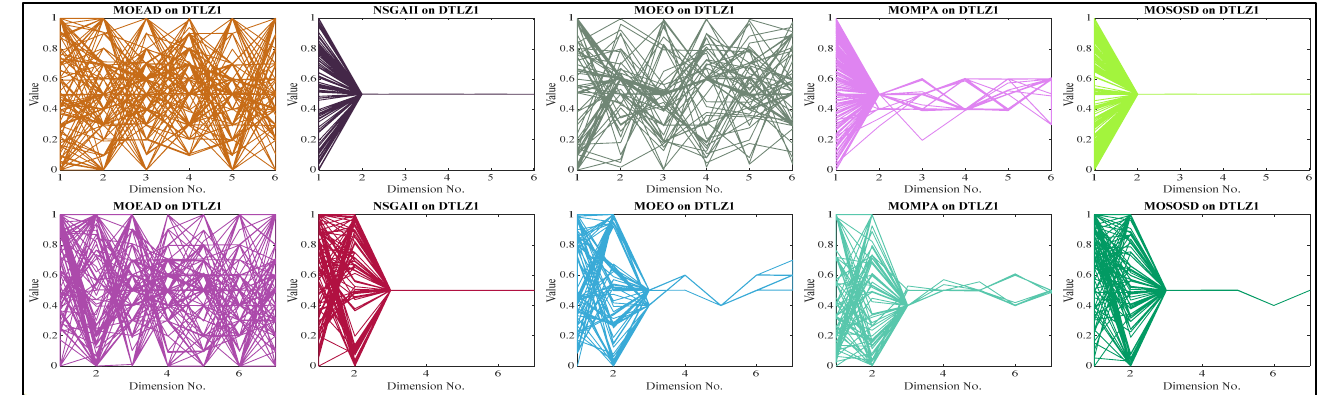
Figure 9. The dimension curve of MOEA/D, NSGA-II, MOEO, MOMPA, and MOSOS/D for DTLZ1 at M = 2, 3.